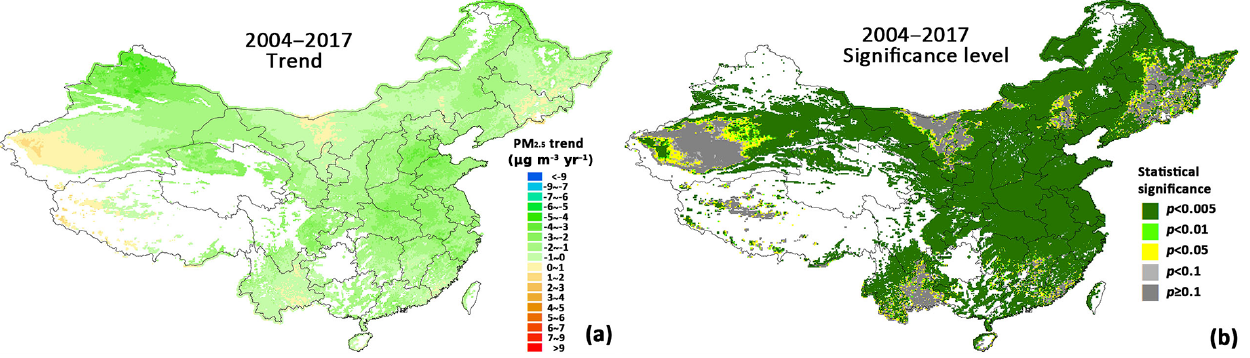
( p< 0 . 005) (Table 2). The trends for YRD and PRD regions are insignificant. During the 10th FYP period, China missed the emission control goals. The emission of sulfur dioxide in- creased by ∼ 28 % (Xue et al., 2014; Schreifels et al., 2012). The 11th FYP for National Economic and Social Develop- ment of China released in 2006 proposed the ECER